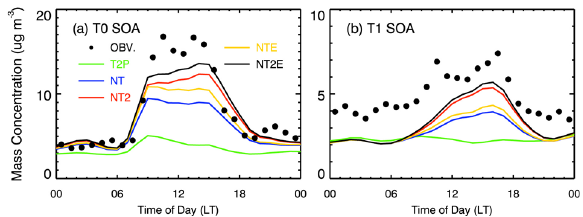
Fig. 12. Diurnal cycles of measured and simulated SOA concentra- tions at T0 and T1 averaged during the period from 24 to 29 March 2006. (a) SOA at T0 and (b) SOA at T1. Black dots: measurements; green line: the T2-SOA model; blue line: the NT-SOA model; red line: the NT2-SOA model; brown line: the NTE-SOA model; black line: the NT2E-SOA model. All the non-traditional SOA models include the SOA contributions from glyoxal and